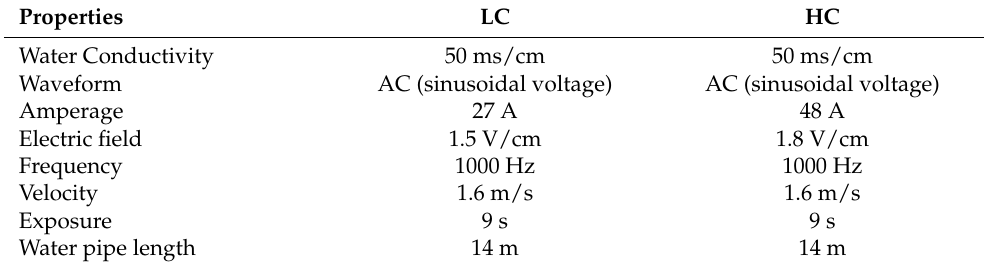
Table 1. Properties of the electric field applied in electrical stunning; the water conductivity, waveform type, amperage, electric field, and frequency for each electrical stunning (LC: Lower current treatment; HC: Higher current treatment) setting are shown; the velocity, exposure, and length of the water pipe are also